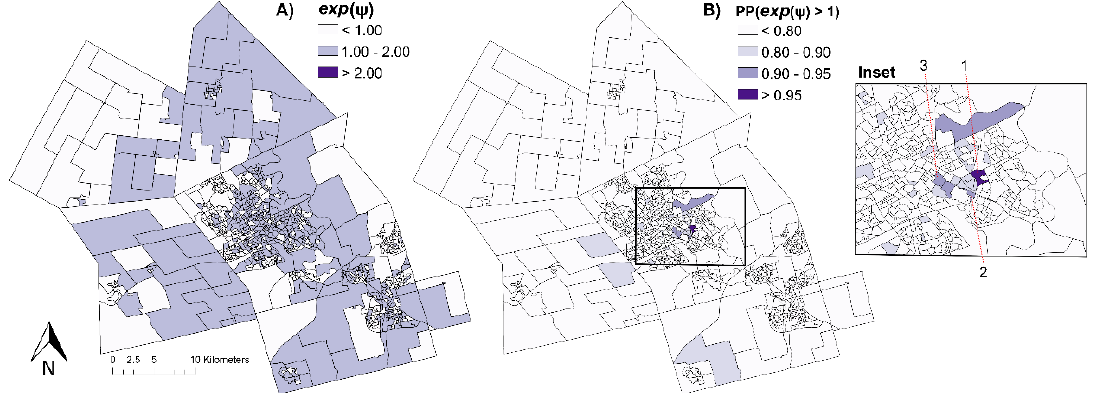
Figure 5. Main spatial effects (= exp(u i + s i )) of police calls-for-service. Figure 6. For 10:00–11:59, ( A ) space-time interaction and ( B ) space-time hotspots.